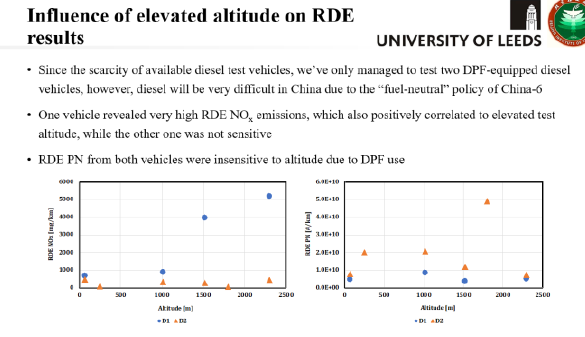
Fig. 13. Exhaust emissions of NO x and PN obtained under Chinese RDE conditions (included extended altitude) [48] Fig. 12. Matrix of suitability and applicability of different types of PEMS Daisy Thomas (University of Leeds, UK) reported on for testing emissions from combustion engines under real operating condi- tions [47] her work on particulate emissions from modern powertrains (in the form of RDE testing of a hybrid passenger